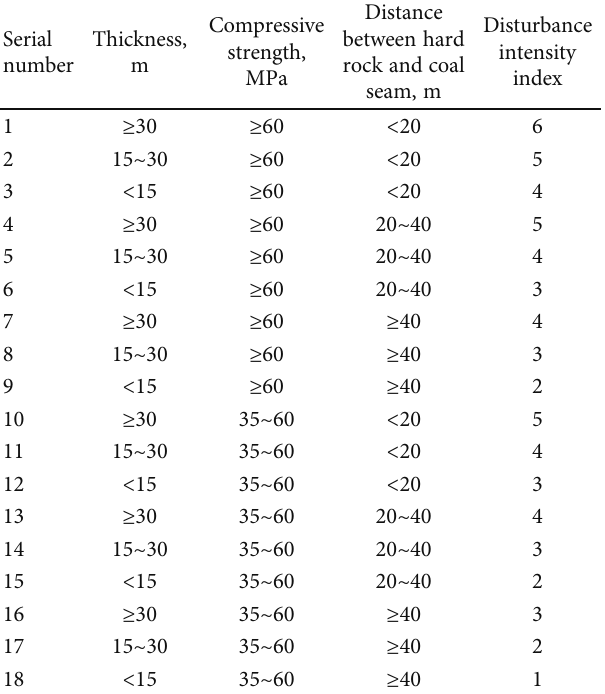
Table 1: Disturbance intensity index of shock-type coal and gas outburst by hard roof.